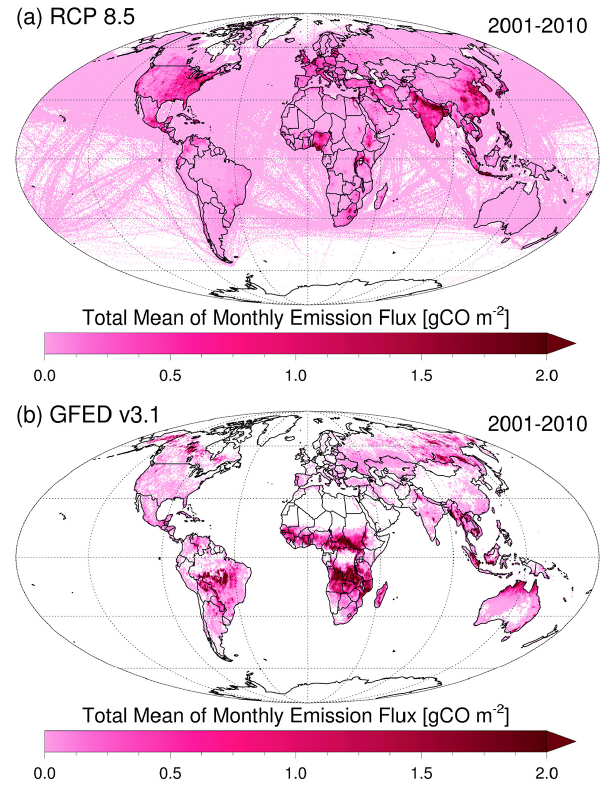
Figure 1. Global distributions of the total mean of monthly CO emission fluxes of (a) RCP 8.5 and (b) GFED v3.1 from 2001 to 2010.